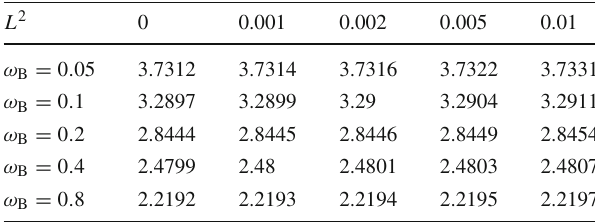
Table1 Theinnermoststablecircularorbitsofparticlesmovingaround a rotating black hole (case for a = 0 . 5 and M = 1)